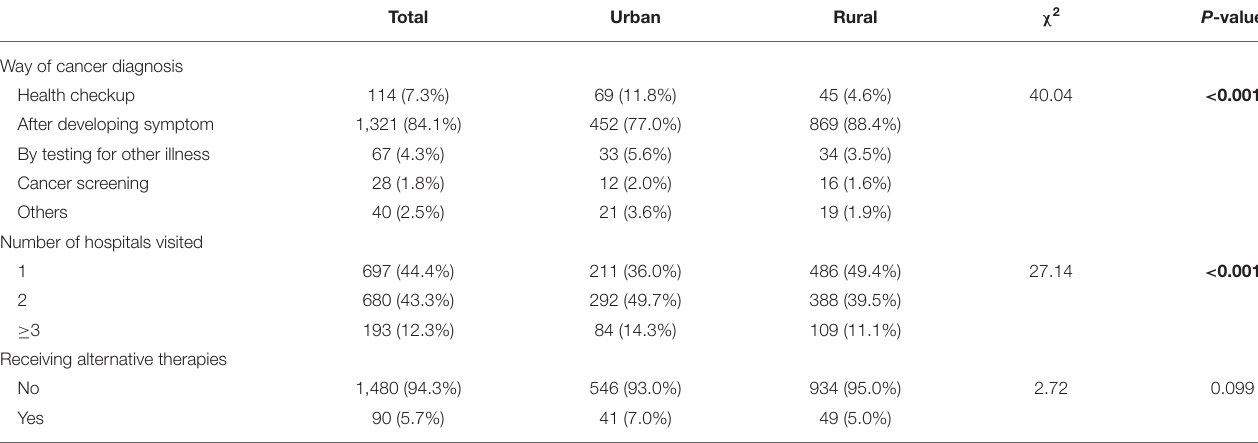
TABLE 2 | Health care utilization and urban-rural disparities among cancer patients (N, %).